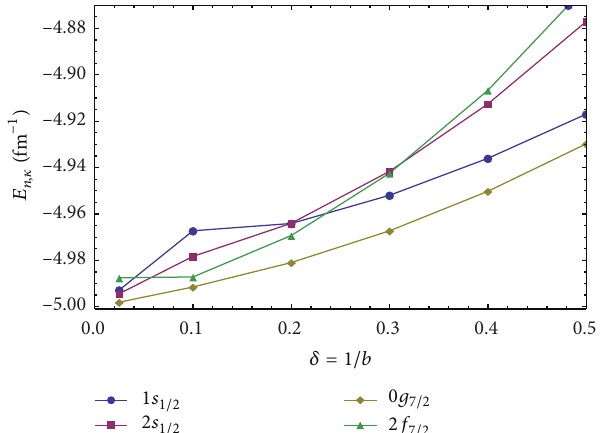
Figure 7: Contribution of the tensor Coulomb potential parameter to the energy levels in the case of p-spin